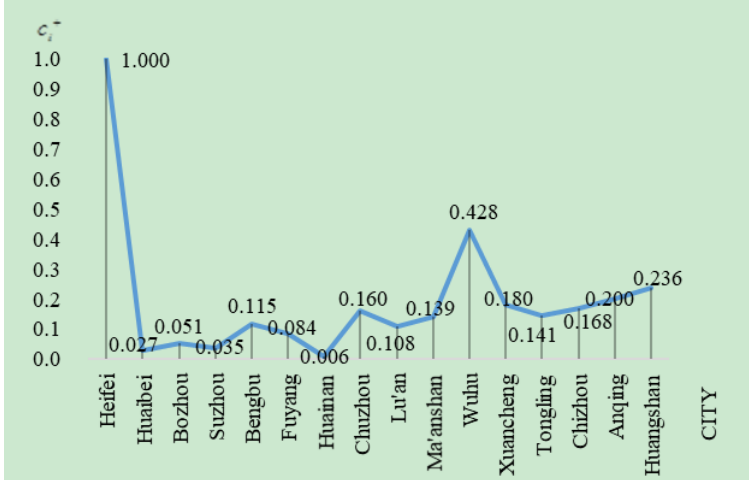
Figure 3. The comparison of sustainability of cities in Anhui Province in 2016.